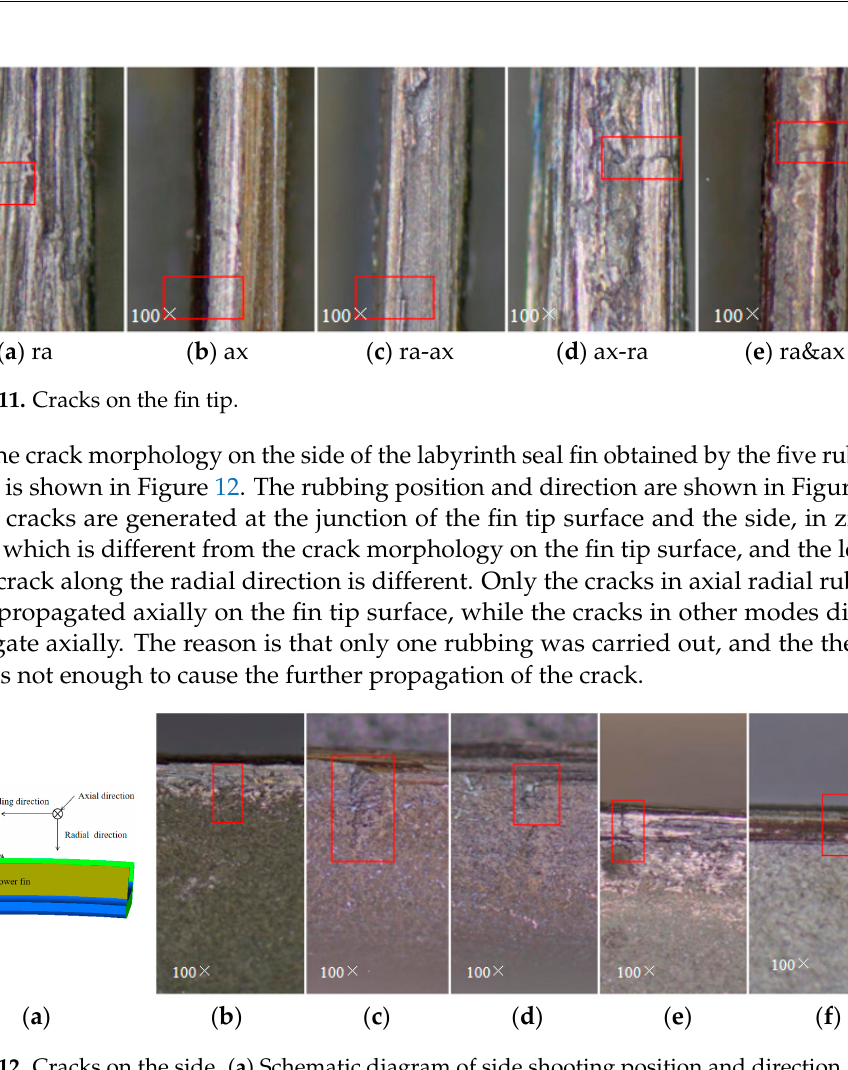
Figure 12. Cracks on the side. ( a ) Schematic diagram of side shooting position and direction. ( b ) ra ( c ) ax ( d ) ra-ax ( e ) ax-ra ( f ) ra&ax.